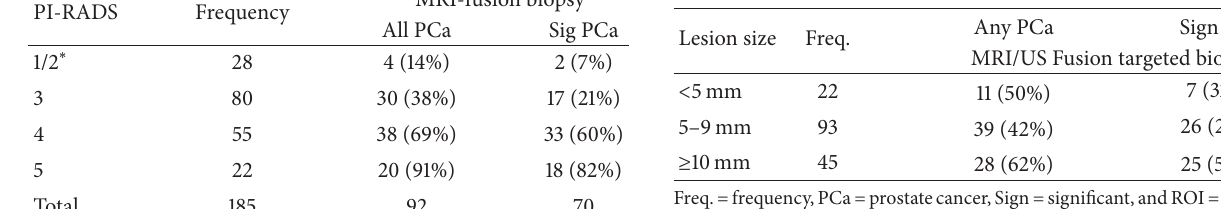
Table 3: Detection rate MRI/US fusion targeted biopsy by size of ROI ( 𝑛 = 148